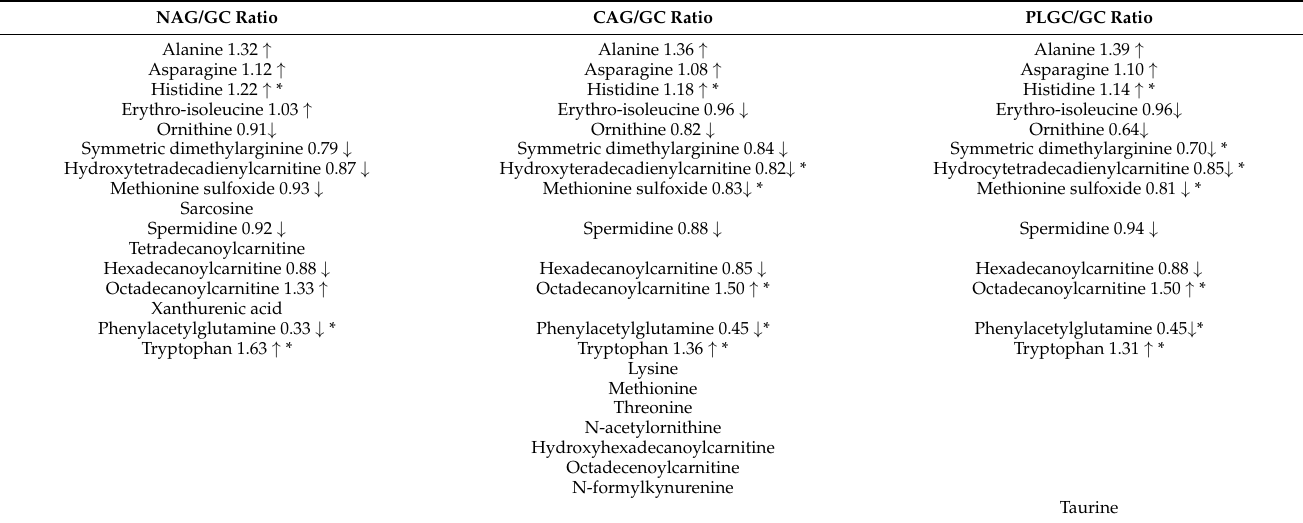
Table 3. The metabolite profile of GC across Correa’s cascade [10].